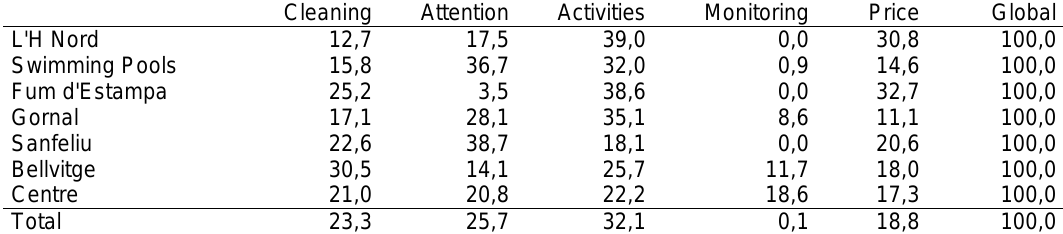
Table 10. Weight of the different aspects in the assessment of the sports facilities (2017). General report. Cleaning Attention Activities Monitoring Price Global